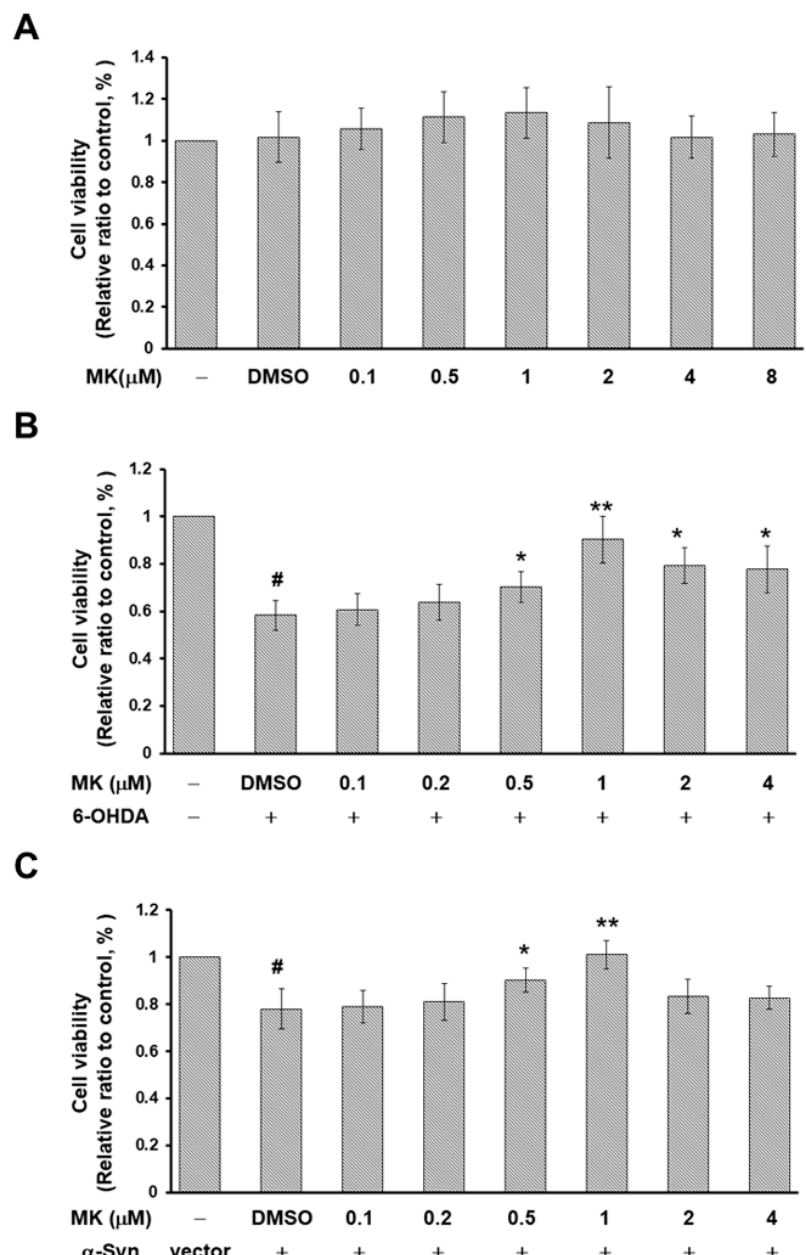
Figure 8. Protective effect of maackiain (MK) against 6 ‐ hydroxydopamine (6 ‐ OHDA) and α‐ synuclein ( α‐ Syn) ‐ induced toxicity in SH ‐ SY5Y cell line. ( A ) Cell viability was measured by the 3 ‐ (4,5 ‐ dimethylthiazol ‐ 2 ‐ yl)2,5 ‐ diphenyltetrazolim bromide (MTT) assay. Cells were pretreated with 0.1, 0.5, 1, 2, 4, or 8 µM MK for 24 h. ( B ) Cell viability was measured by MTT assay. Cells were pretreated with 0.1, 0.2, 0.5, 1, 2, or 4 µM MK for 24 h and were then exposed with 100 µM 6 ‐ OHDA for an additional 24 h. # shows significant differences between 6 ‐ OHDA ‐ exposed and control cells (# p < 0.001,); * shows significant differences between the MK ‐ pretreated 6 ‐ OHDA ‐ exposed and MK ‐ untreated 6 ‐ OHDA ‐ exposed cells (* p < 0.05, ** p < 0.01). ( C ) α‐ Syn ‐ overexpressing cell viability was measured by MTT assay. α‐ Syn ‐ overexpressing cells were pretreated with 0.1, 0.2, 0.5, 1, 2, or 4 µM MK for 24 h. # shows significant differences between α‐ Syn ‐ overexpressing and control cells (# p < 0.01); * shows significant differences between the α‐ Syn ‐ overexpressing MK ‐ pretreated and α‐ Syn ‐ overexpressing MK ‐ untreated groups (* p < 0.05, ** p < 0.01).